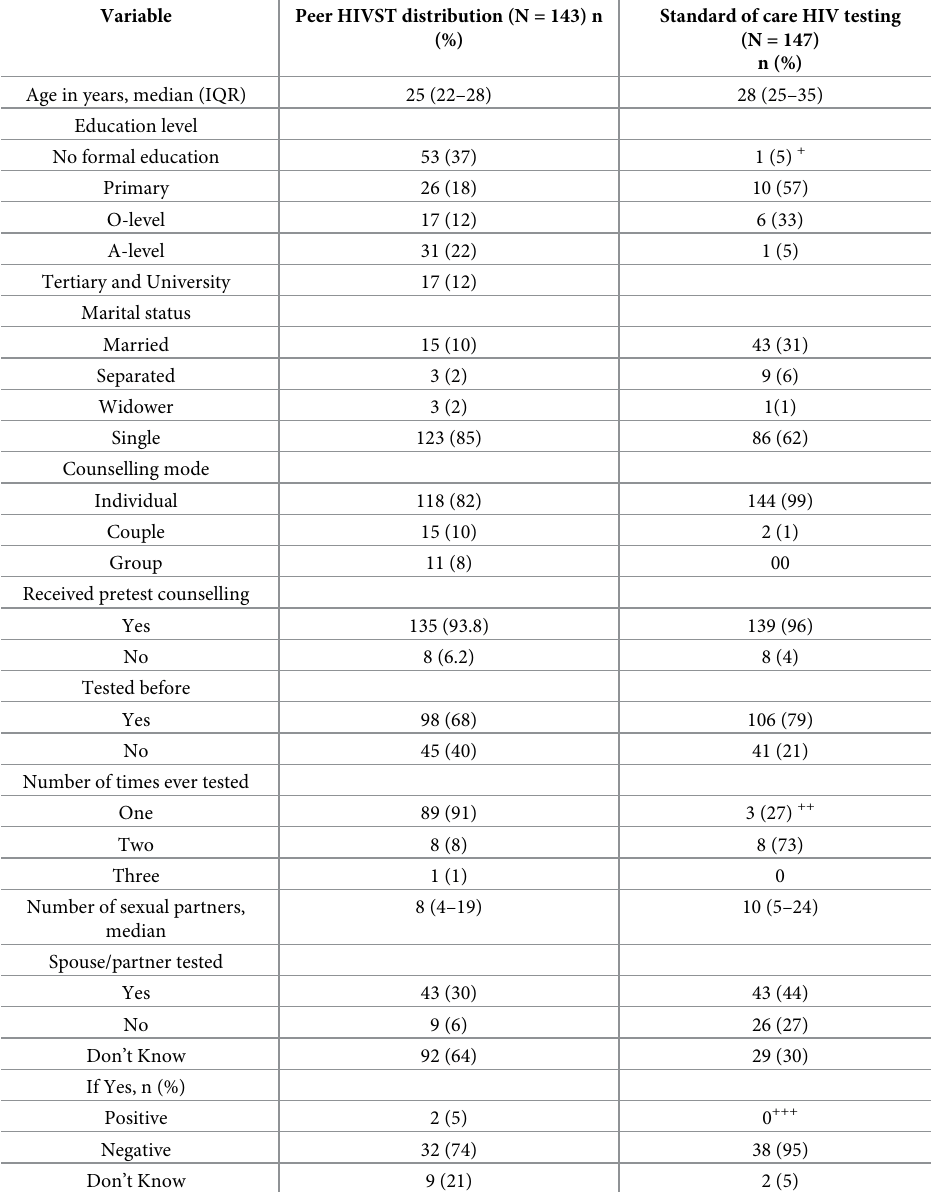
Table 1. Demographic characteristics.